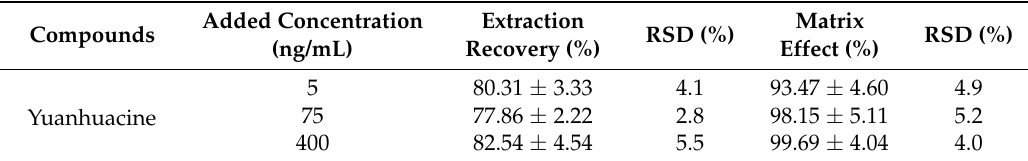
Table 2. The extraction recovery and matrix effect of yuanhuacine in rat plasma ( n = 6).